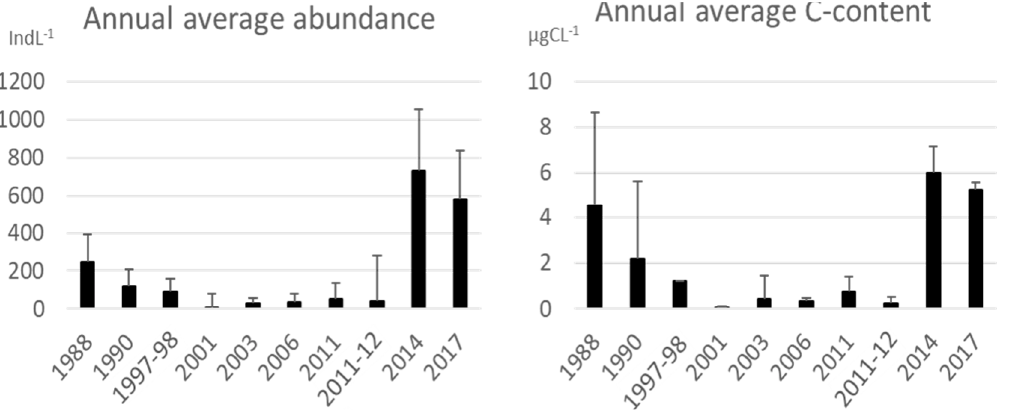
Figure 8. Annual average abundance (indL − 1 ) and annual average carbon content (µgCL − 1 ) of tintinnids dets. Sample numbers for each year are provided in Table S2.